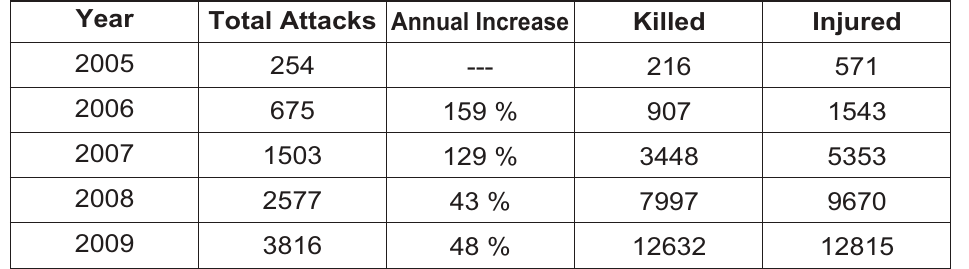
Table- 3 Details of terrorist attacks during 2005-2009